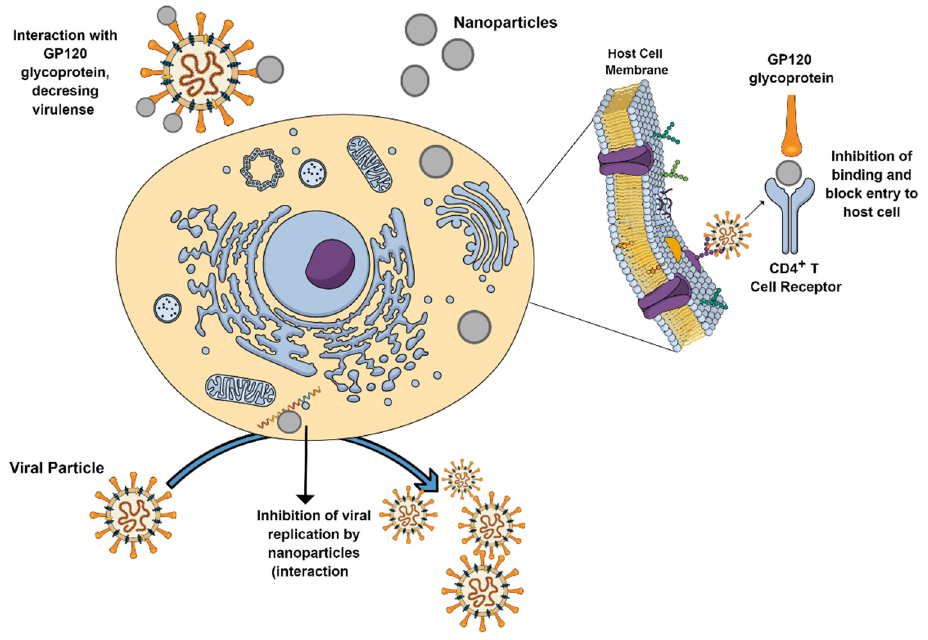
Figure 3. Main described action mechanisms by which metal-based NPs can act against viruses.